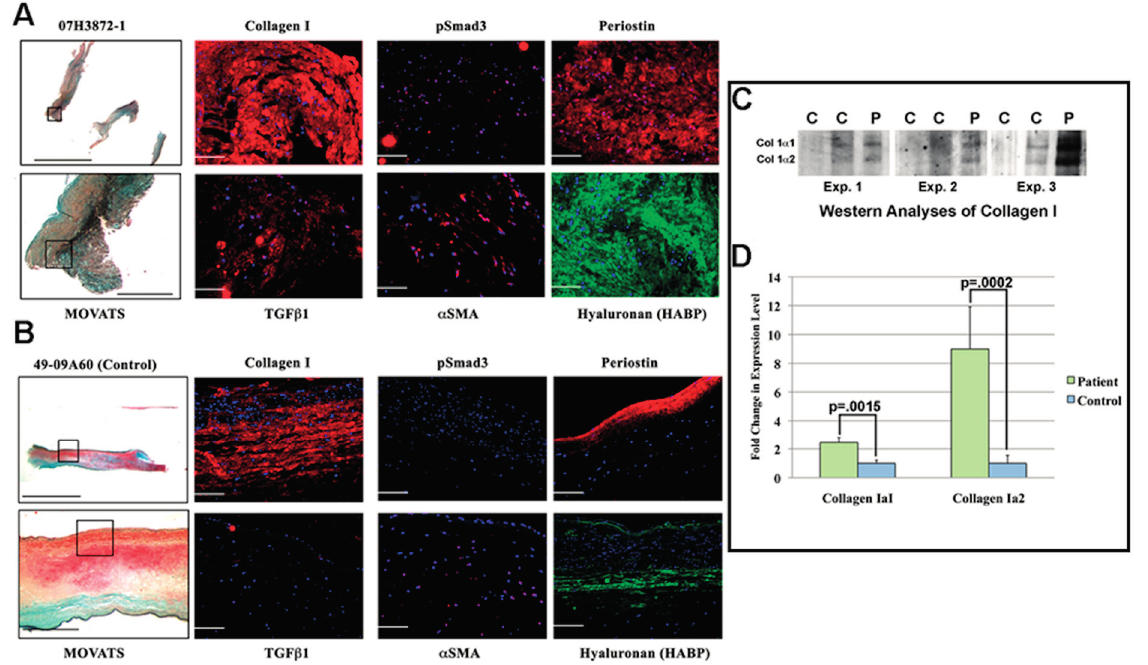
Figure 6 . Comparison of excised MVs in an HCM patient with a MYBPC3 mutation and in two normal hearts (controls, n = 2). Findings in the patient ( A ) and in a representative control ( B ) with histological (Movat’s) and immunohistochemical stainings are shown. Boxed areas represent regions where protein stainings were captured. ( A ) The MV from the HCM patient exhibits a disruption of the normal stratified layers of the mitral leaflets with an increase in TGF β downstream extracellular matrix proteins (collagen I, periostin, and hyaluronan). Higher levels of TGF β 1 were observed in the leaflets of the HCM